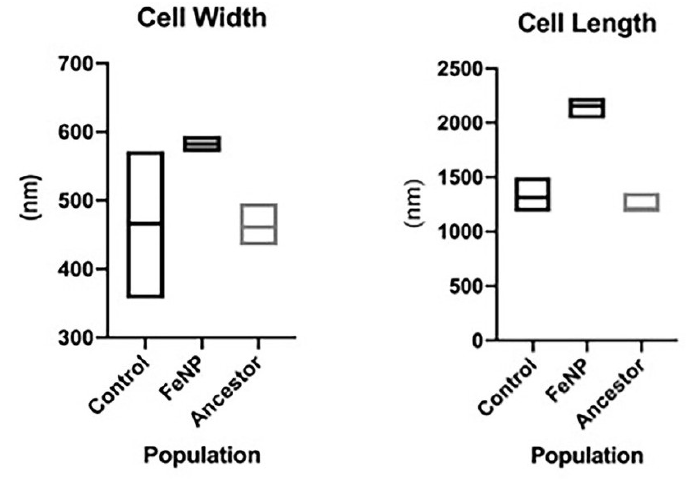
Figure 4. Bacteria cell width and length distribution . Box plots of E. coli MG1655 mean cell width and length for FeNP compared to controls and ancestors is shown. The sample size was N = 20 cells per replicate population measures in the FeNP and control populations for a total of 100 cells per selection treatment. Sample size for ancestors was 15 for each replicate, for a total of 75